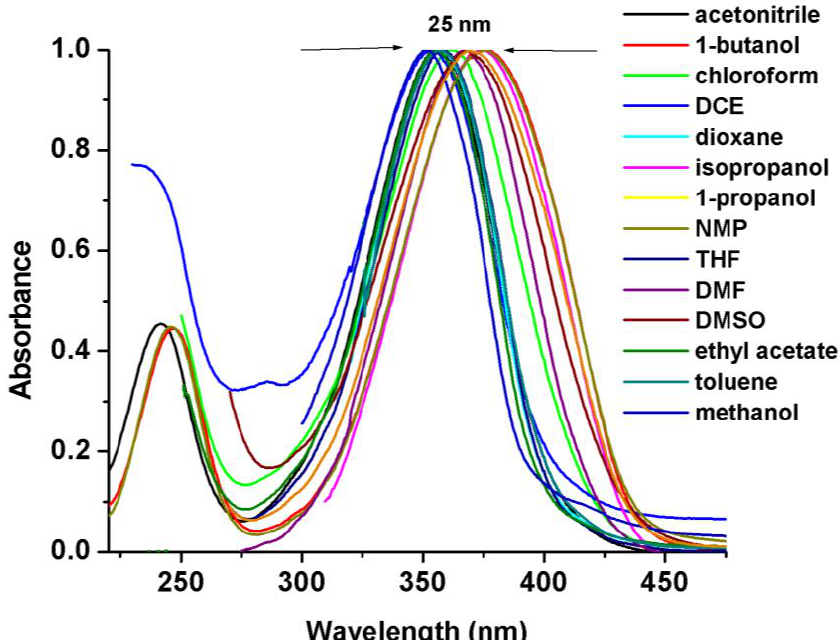
Figure 2. Normalized UV-Vis absorption spectra of BZCH in selected solvents.